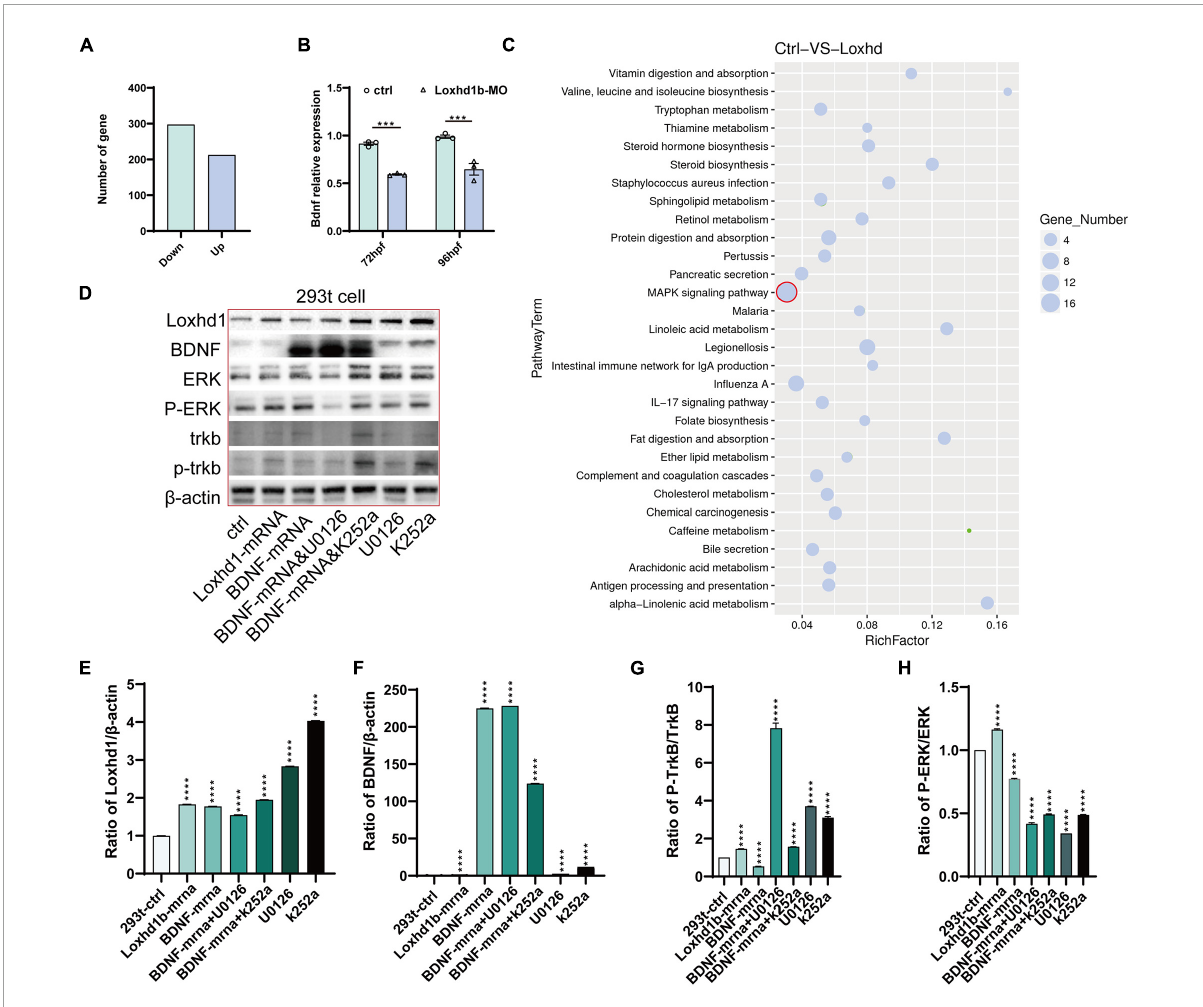
FIGURE6 BDNF/TrkB/ERK signaling pathway regulated by the Loxhd1b gene in zebrafish auditory development. (A) Clustering analysis showing the replicates within group with a sound repeatability, while the control and mutated group are different in the clustering. (B) Volcano diagram of differentially expressed genes. Red and blue dots indicate up-regulated and down-regulated genes, respectively. Abscissa indicates gene fold change in different samples; ordinate represents statistical significance of gene expression change. (C) KEGG analysis of the differentially expressed genes. The vertical and horizontal axes represent the pathways and the Rich factor, respectively. The size of the dot indicates proportionally the number of differentially expressed genes in the pathway, and the color of the dot corresponds to a different Q value range. (D–H) Detection of protein expression of Loxhd1b , BDNF, TrkB, P-TrkB, ERK, and P-ERK based on chemiluminescence imaging system. *** P < 0.001 and **** P <